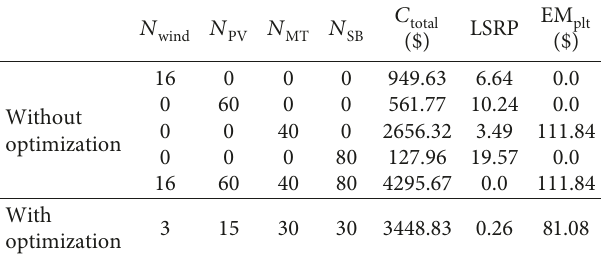
Table 12: Comparison of the optimization